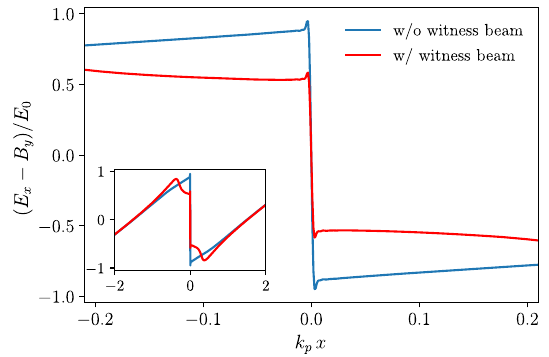
FIG. 4. Transverse wakefield amplitude, ð E x − B y Þ =E 0 , versus transverse position, k p x , for k p ζ ¼ − 11 . 6 (cf., Fig. 2). The blue line depicts the focusing fields without any witness beam, and the k R red line denotes the focusing fields in the beam-loaded case, p p . where the Gaussian witness beam parameters are given by ˆ n =n ¼ 500 , σ ¼ 0 . 025 k − 1 σ ¼ 0 . 5 k − 1 b 0 x;y z p , and p . Inset: Trans- verse wakefields for a wider x